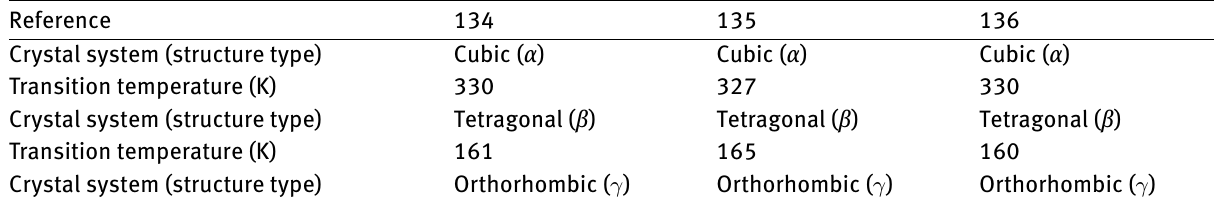
Table 2: Crystal systems and transition temperatures of CH 3 NH 3 PbI 3